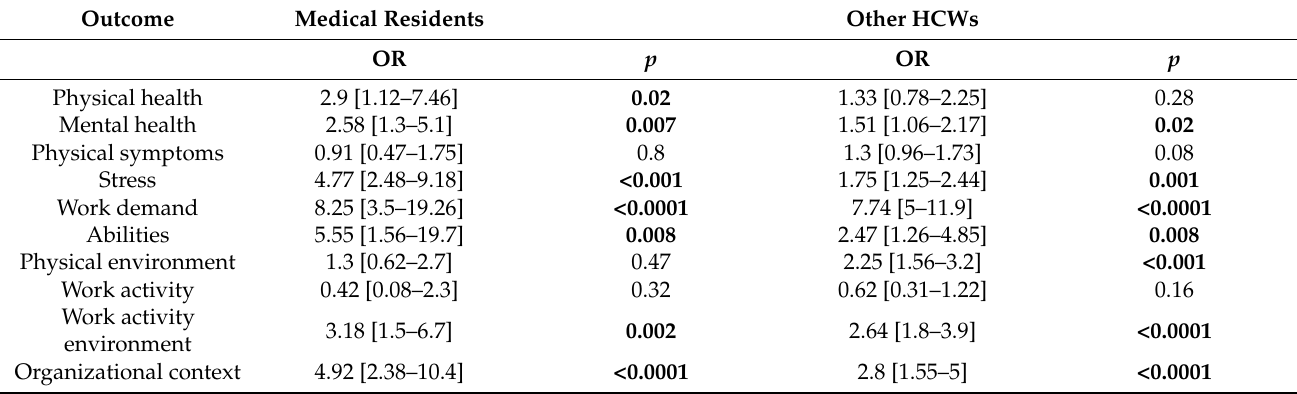
Table 3. Multivariate analysis adjusted for confounders including, gender, age, years at workplace. Associations between risk factors and outcomes are presented as odds ratio and 95% confidence